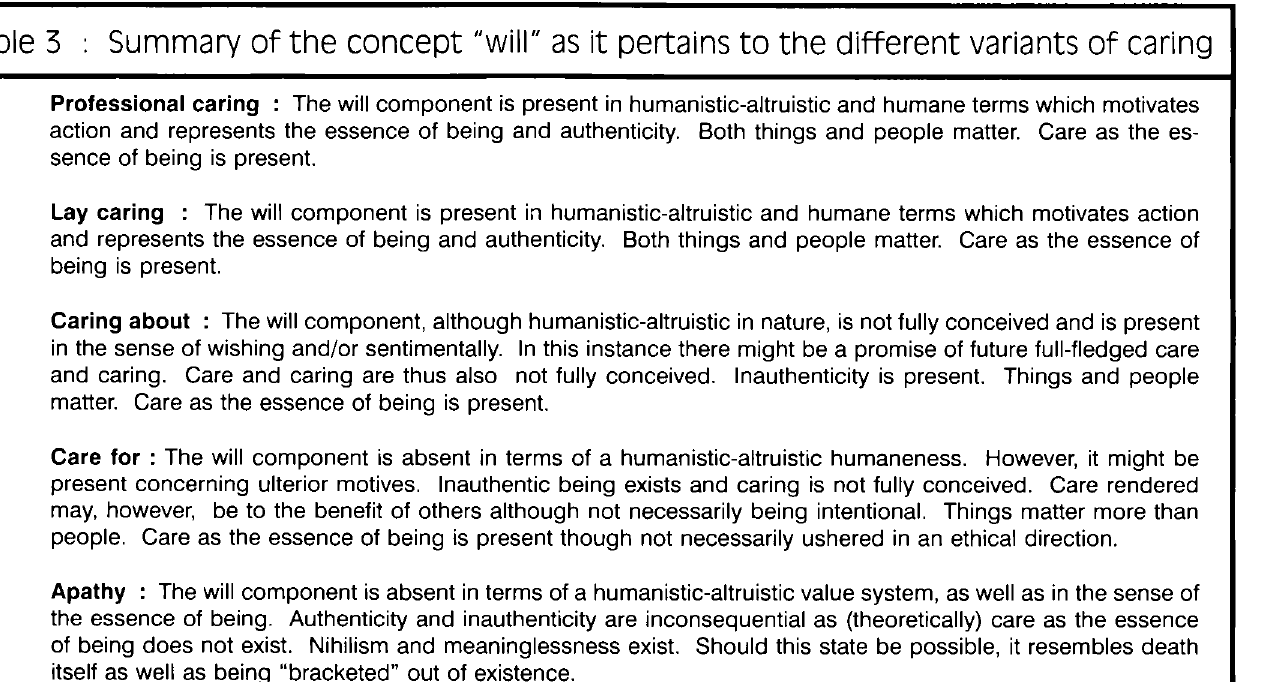
Table 3 : Summary of the concept "will" as it pertains to the different variants of caring Professional caring : The will component is present in humanistic-altruistic and humane terms which motivates action and represents the essence of being and authenticity. Both things and people matter. Care as the es­ sence of being is